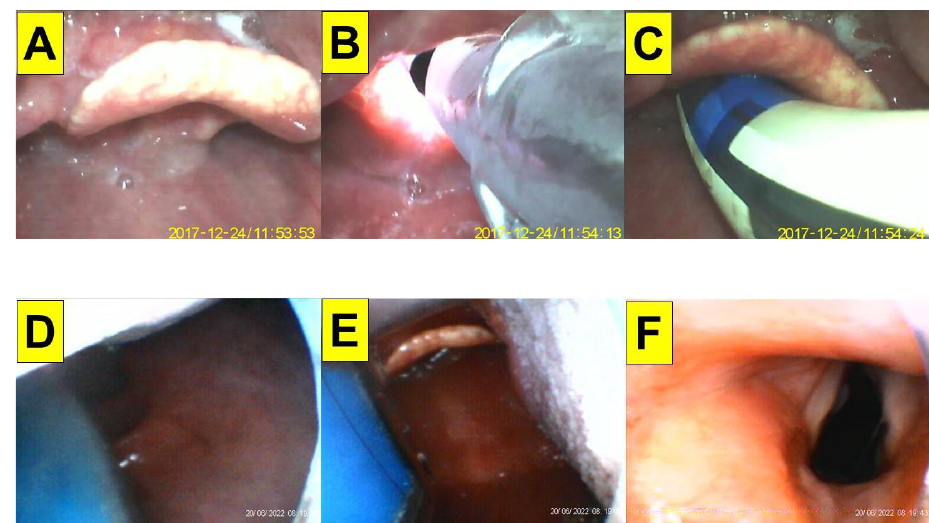
Figure 6. Application of video-twins technique in a patient underwent thyroidectomy. A 73-year-old woman with a BMI 31.5 kg/m 2 . Intraoperative neuromonitoring (IONM) was used. Mallampati class III and Cormack-Lehane laryngoscopic view grade 2b: ( A – C ) videolaryngoscopic views.; and ( D – F ) views from intubating stylet. The proper position of the IONM tube over the vocal cords was confirmed ( C ). Intubation time was 9 s. (also see the Supplementary Materials — Videos S8 and S9). Intubating devices: UE and Trachway.